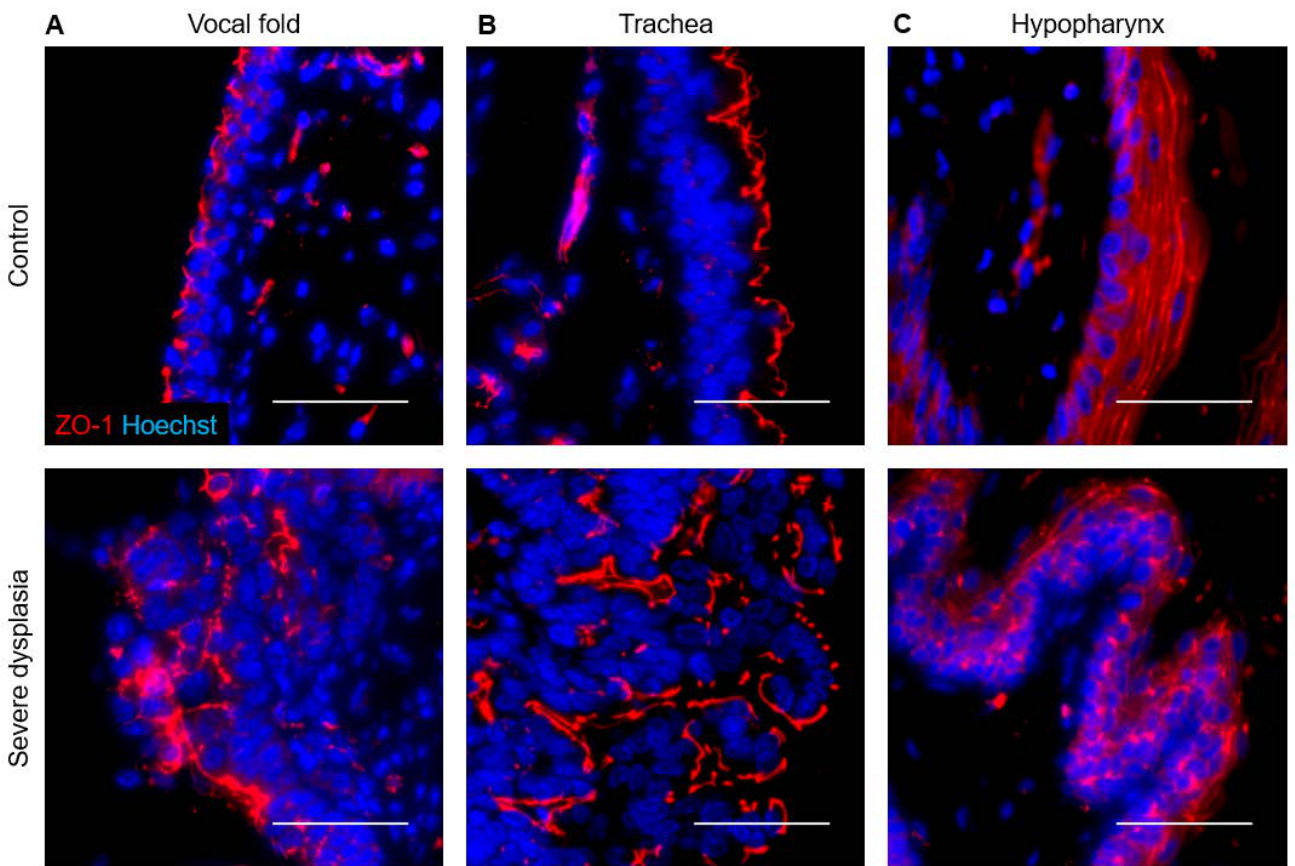
Figure 8. Disorganized ZO-1 in MmuPV1-induced severe dysplasias. Control and diseased tissues costained for ZO-1 (red) and Hoechst (blue) IF. Top row: 40× magnification. Bottom row: higher magnification of areas indicated by boxes. Scale bars = 50 um. ( A ) Vocal fold. ( B ) Trachea. ( C ) Hypopharynx.